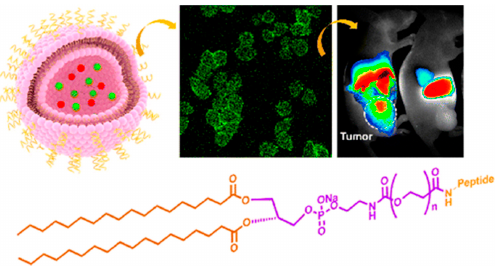
Figure 7. Schematic presentation of functionalized liposomes (pink sphere) with breast cancer targeting peptide (purple structure) and confocal images of liposomes (green spheres) in fluorescein isothiocyanate